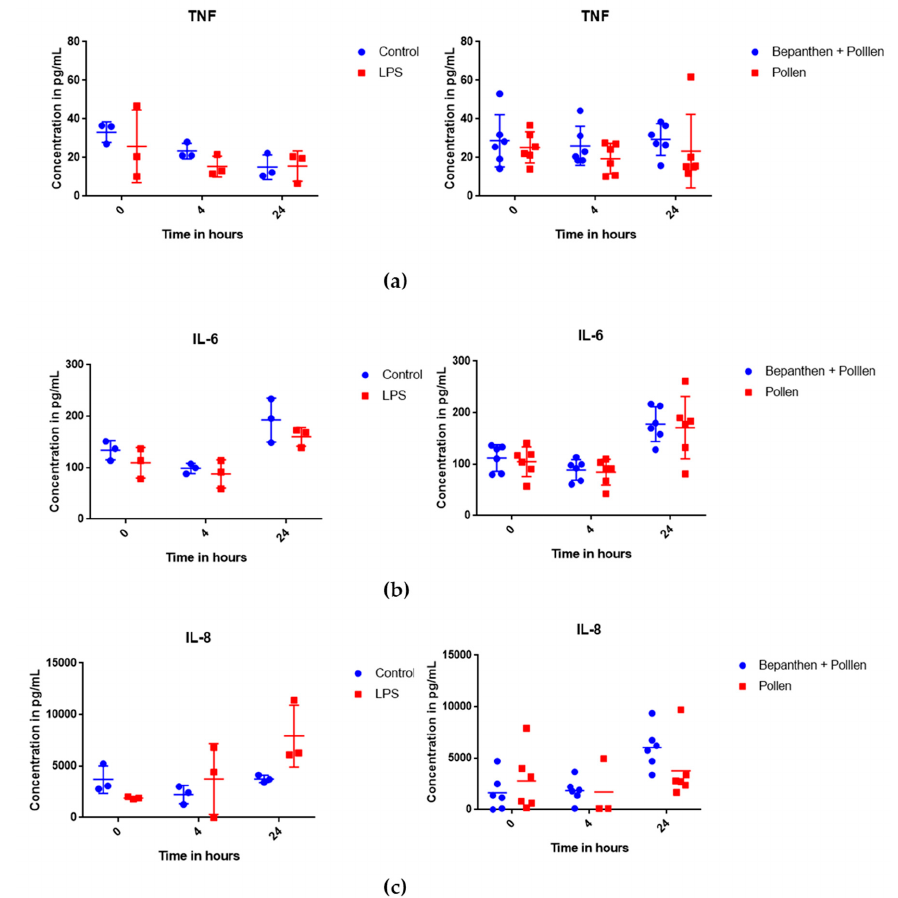
Figure 5. Cytokine release of MucilAir™ with pollen deposition on Bepanthen ® Eye and Nose Ointment (n = 6 per time point and group) and control with lipopolysaccharides (LPS) stimulation over 24 h (n = 3 per time point and group); ( a ) release of TNF- α ; ( b ) release of Interleukin-6; and, ( c ) release of Interleukin-8 (dilution of 1:1000).